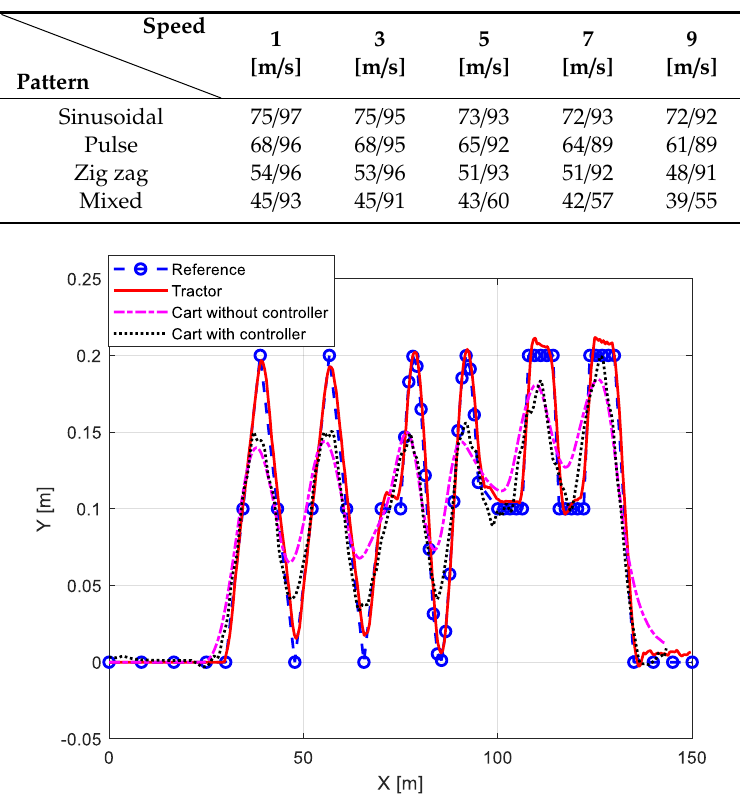
Table 6. Coverage percent (without controller / with controller).